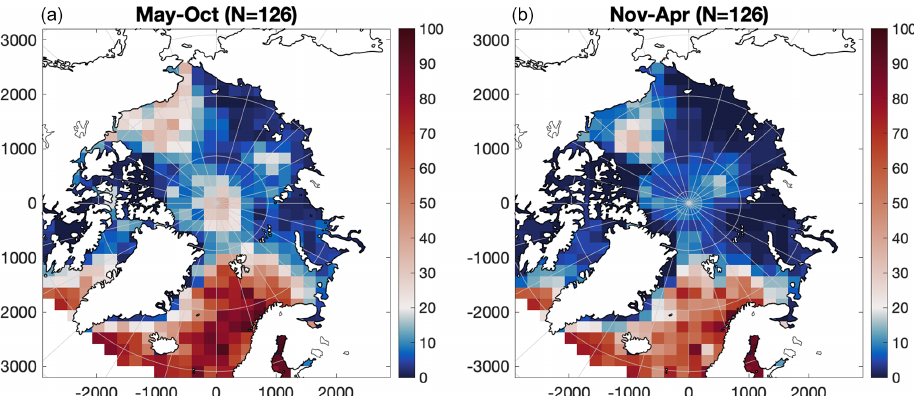
Figure 3. Percentage of months with available T – S data in 200km × 200km grid cells. (a) Summer months (May–October). (b) Winter months